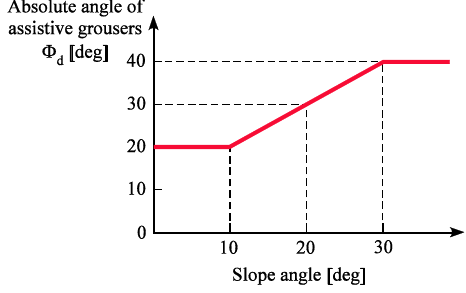
Figure 16. Proposed method of setting the target angle Φ d (Figure 3c) in a real